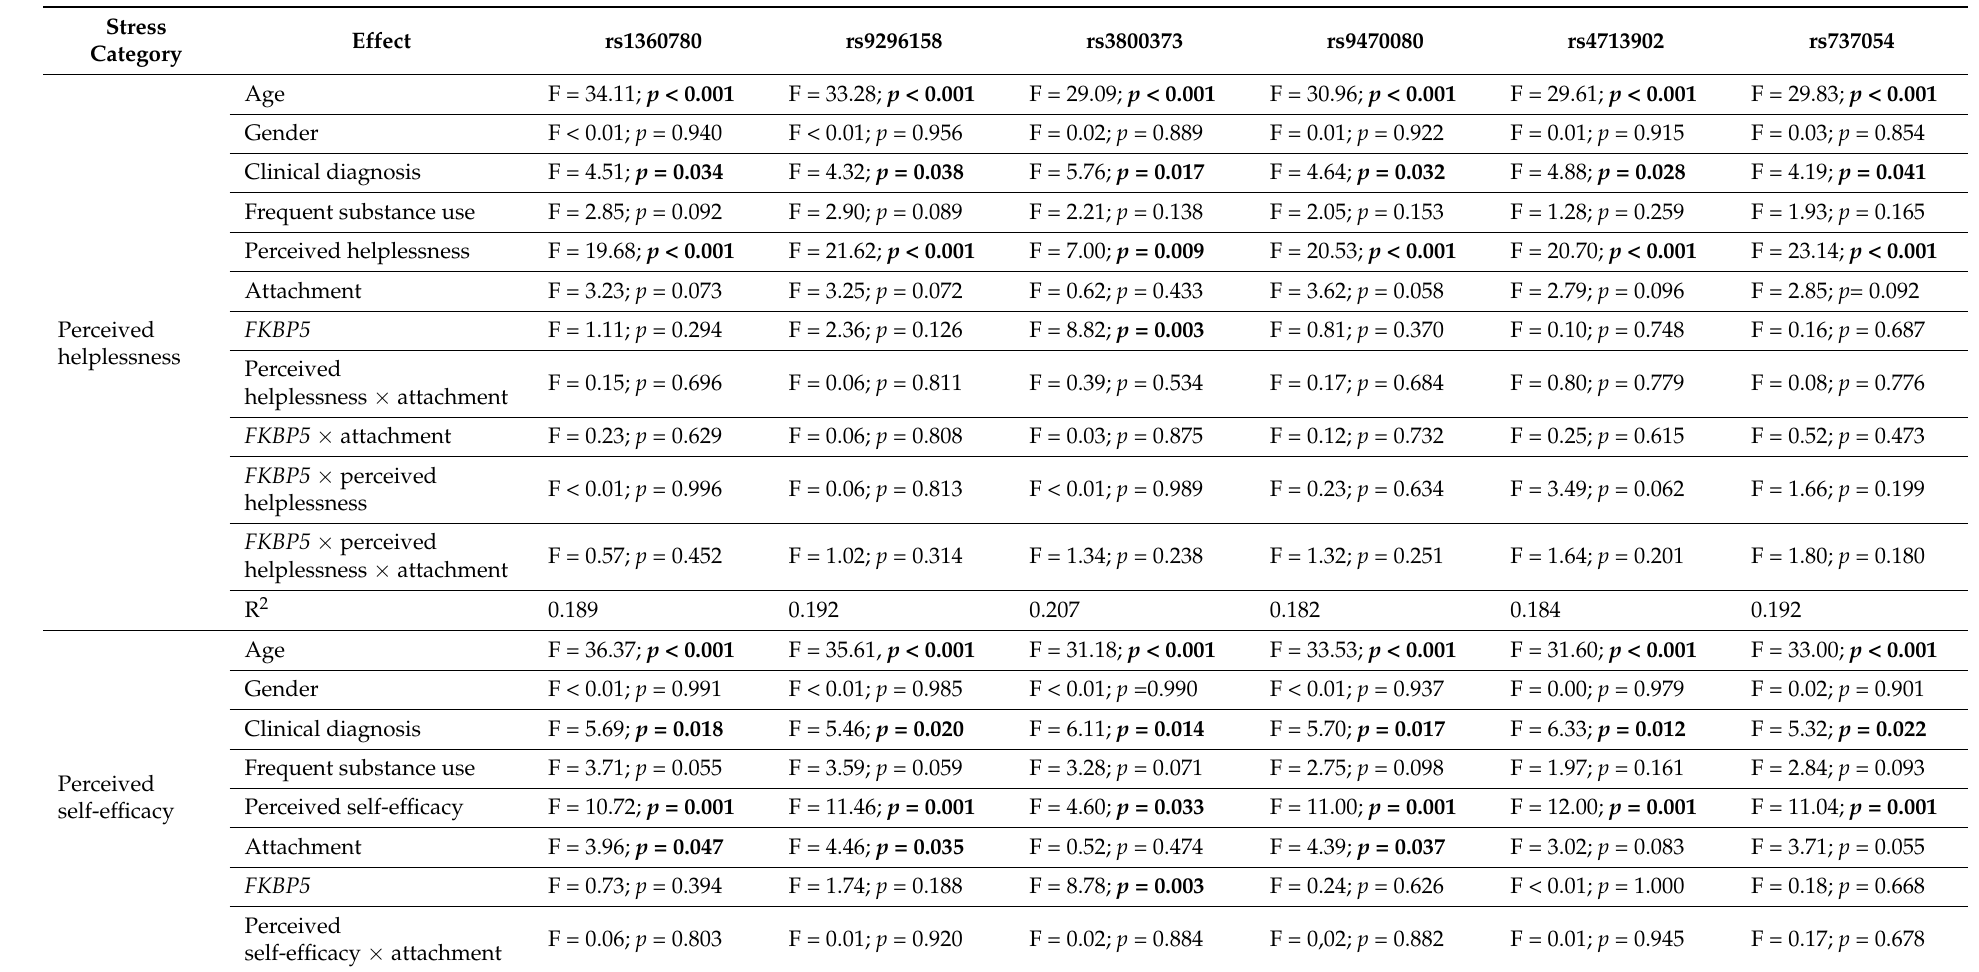
Table 3. Interactions between the FKBP5 gene polymorphisms, perceived stress and attachment style (effects of exposure, covariates and